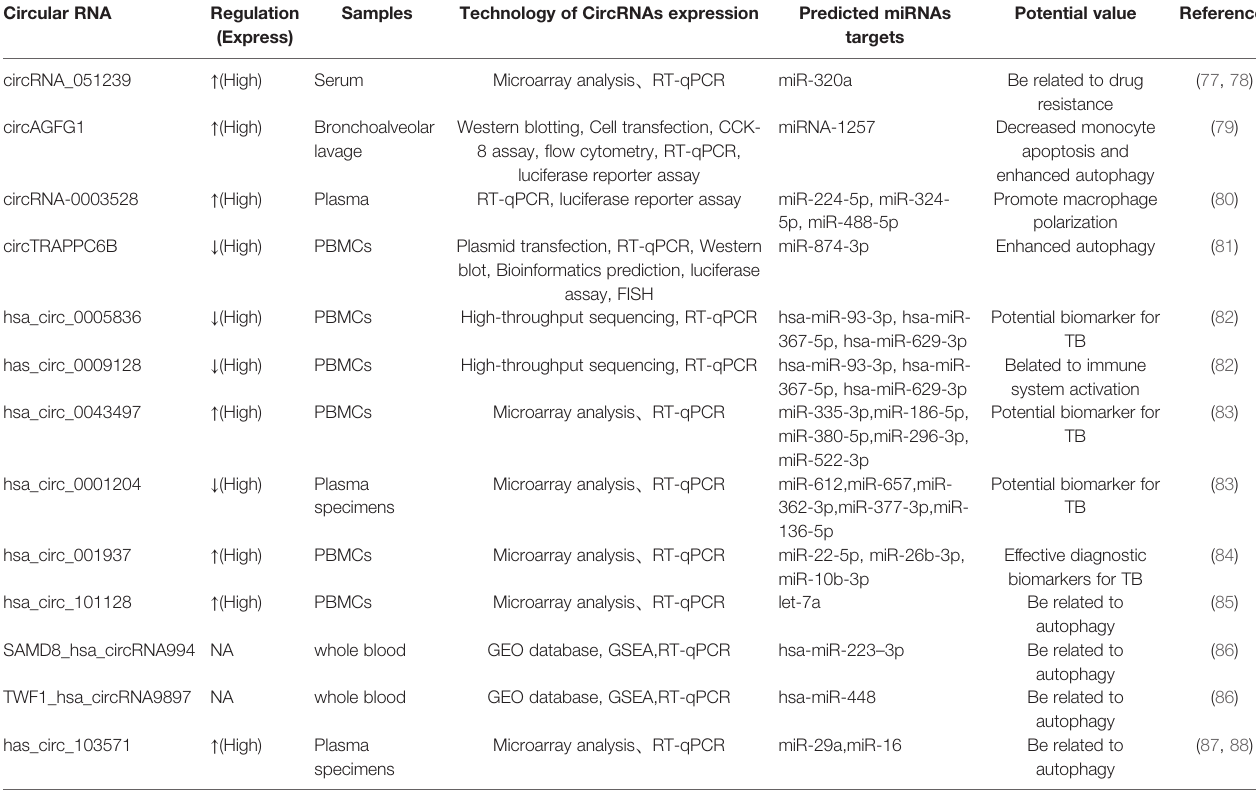
TABLE 4 | The regulatory role of CircRNAs in anti-TB immunity. Circular RNA Regulation